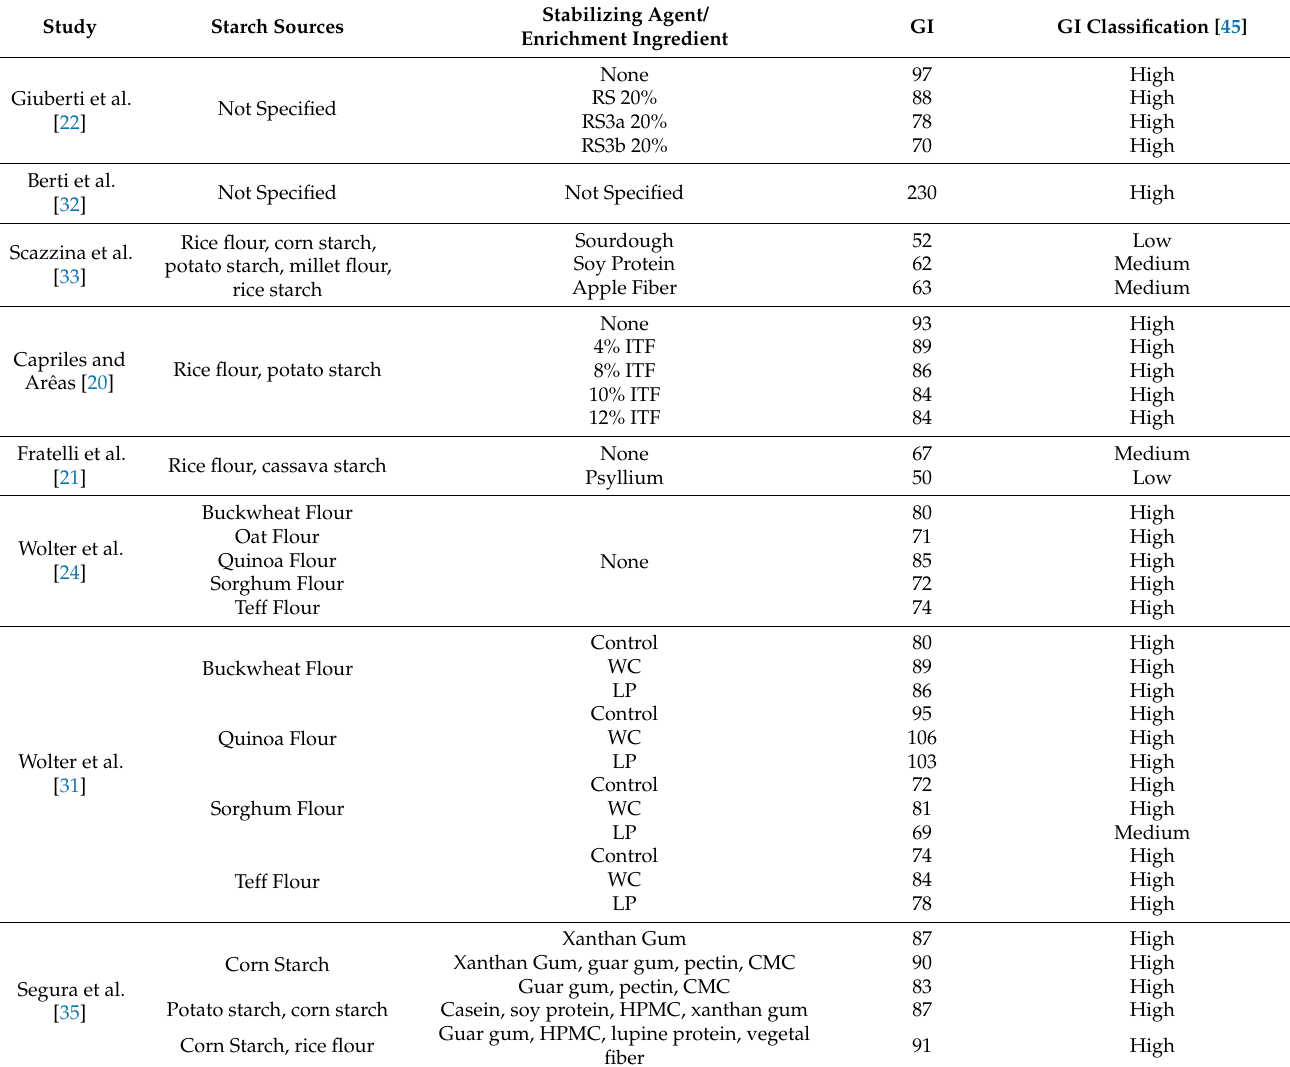
Table 2. Main ingredients and Glycemic Indexes of gluten-free bread (GFB) presented in the